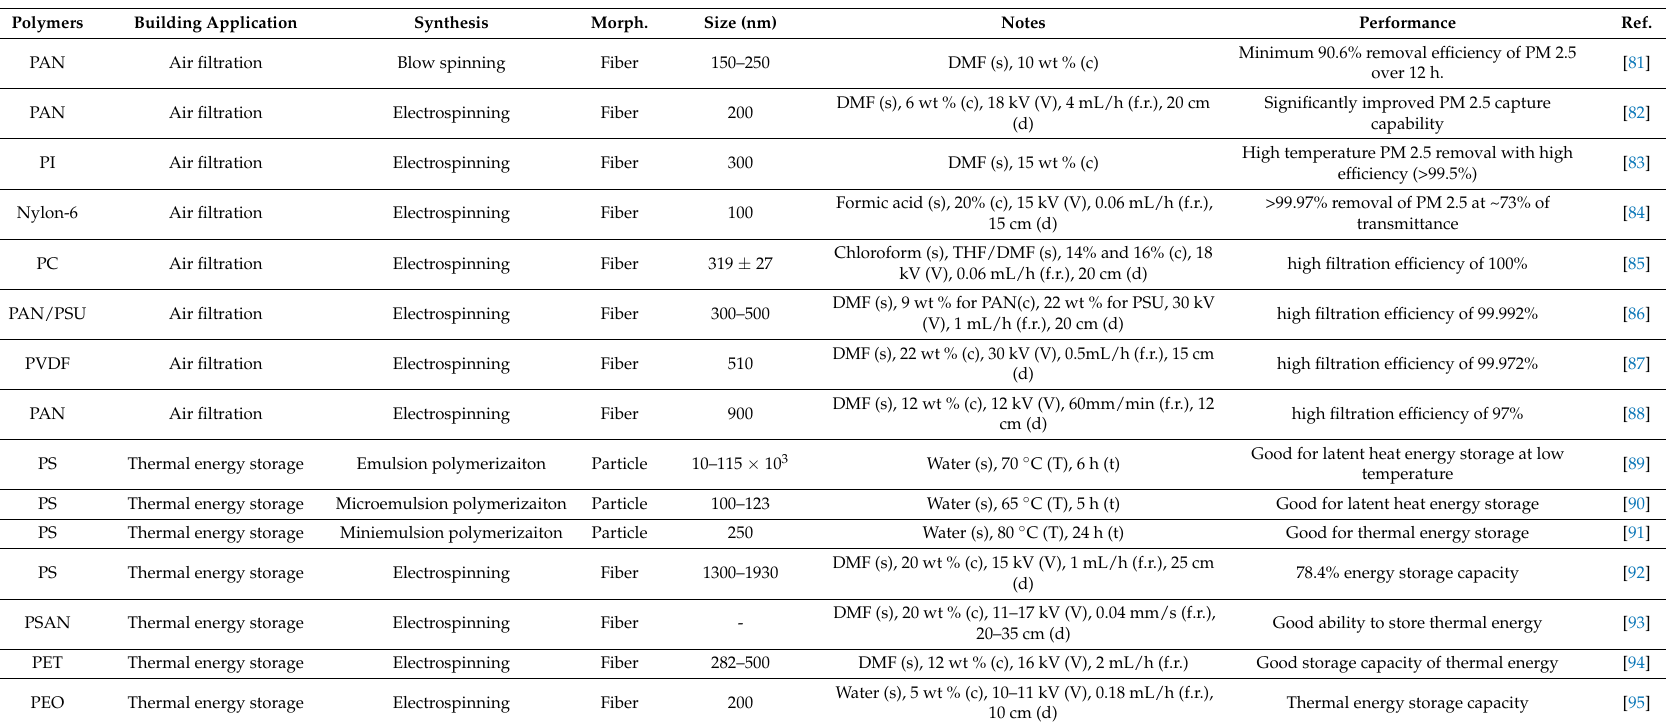
Table 3. Representative Building Applications of Polymers Used in Construction